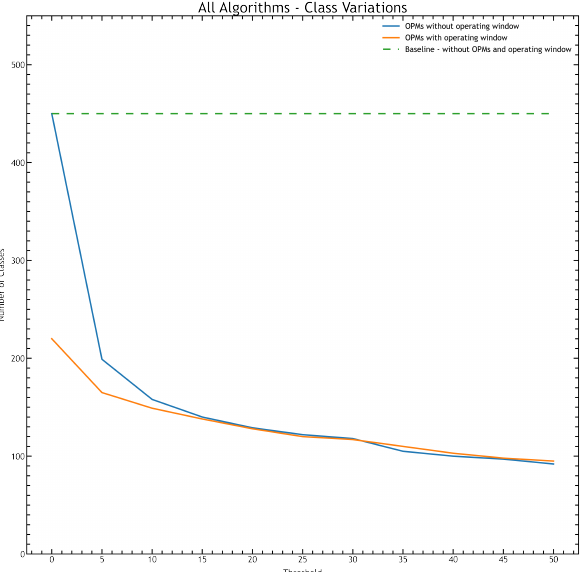
Figure 6. Unique class variation with respect to OPMs and power